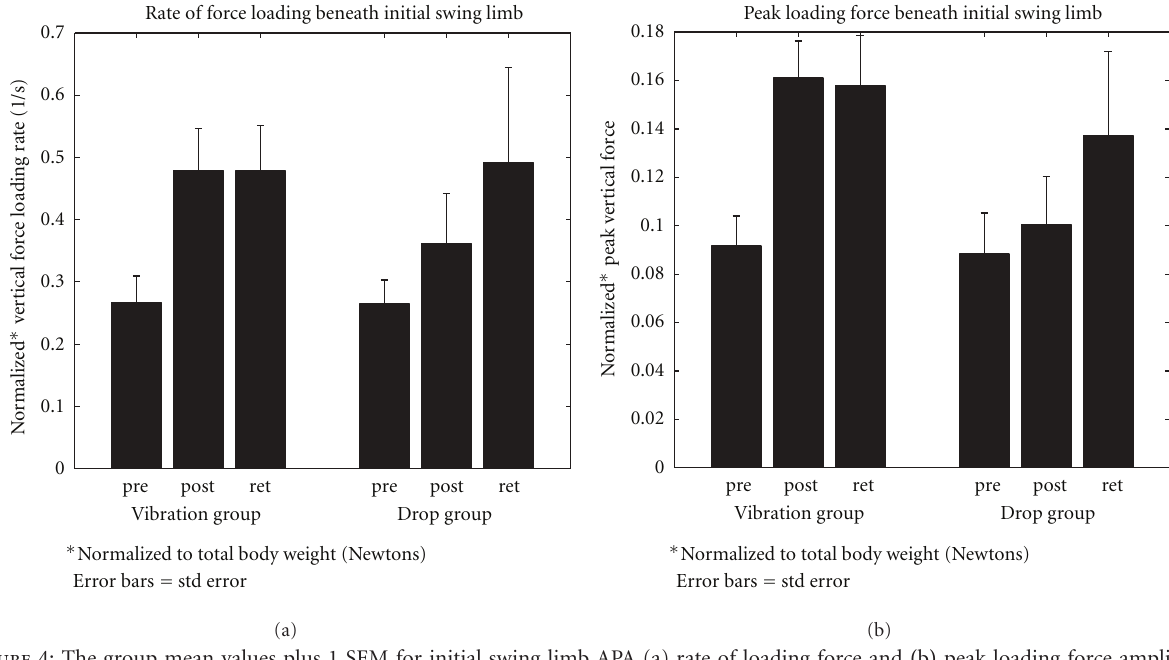
Figure 4: The group mean values plus 1 SEM for initial swing limb APA (a) rate of loading force and ( b ) peak loading force amplitude measured at baseline prior to posture assist locomotion (PAL) training (pre), immediately after training (post), and six weeks after the completion of training (ret) PD subjects in drop assist and vibration assist training groups. Unpublished